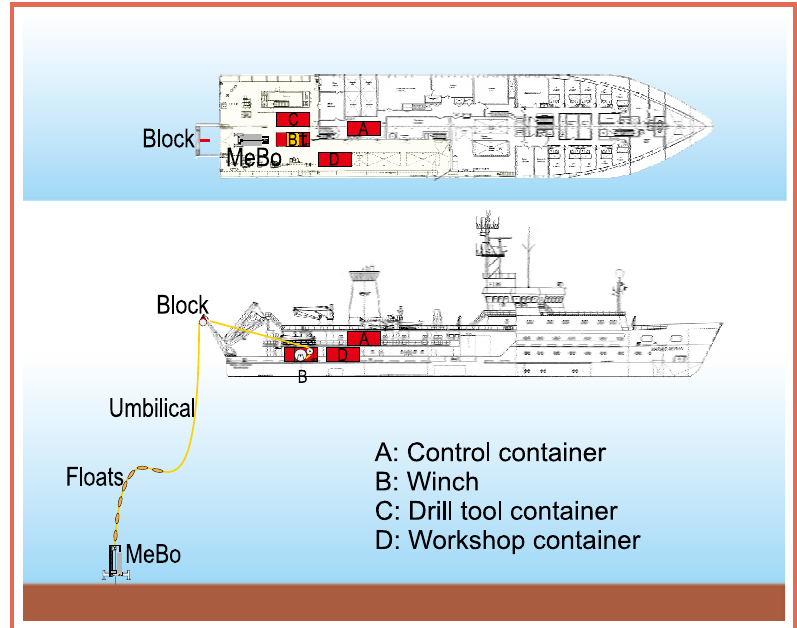
Figure 1. Schematic deployment scheme of the sea floor drill rig MeBo exemplified for RV Maria S. Merian